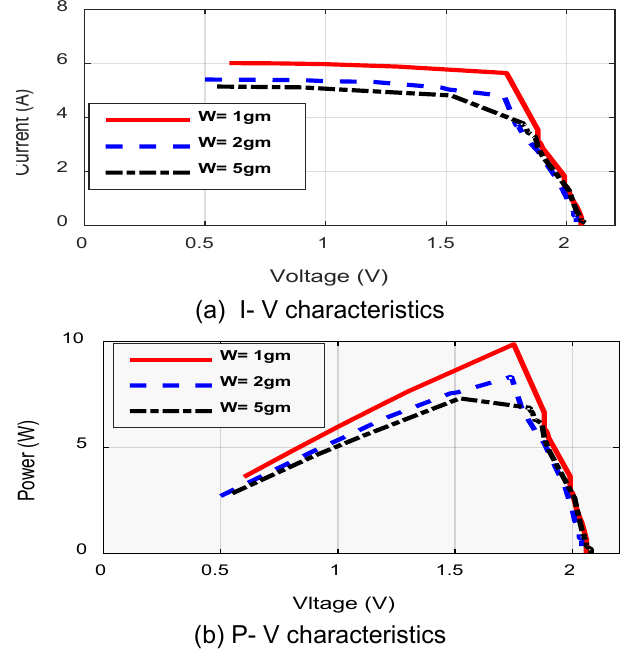
Figure 14. I-V and P-V characteristics of Brick furnace dust with reflector at irradiation 500W/m 2